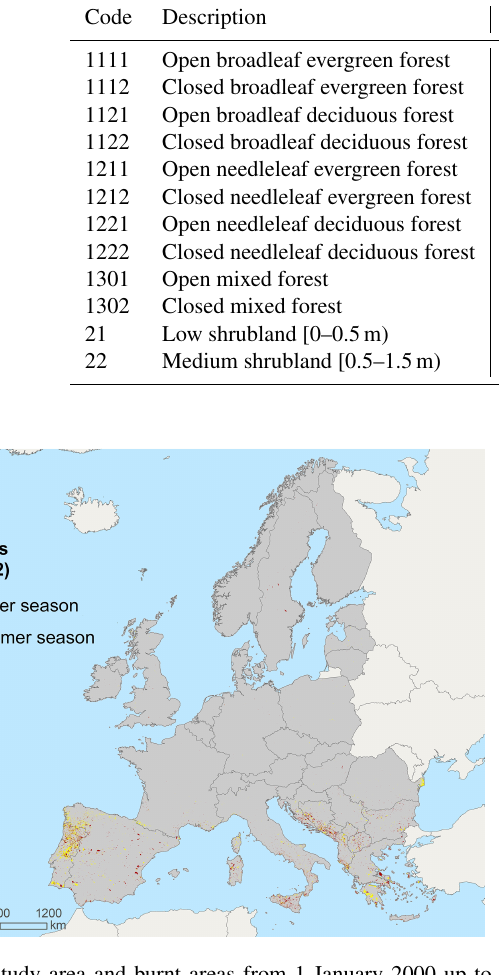
Figure 2. Study area and burnt areas from 1 January 2000 up to 27 January 2022 in winter and summer seasons. Note: source data for the burnt area have been taken from EFFIS